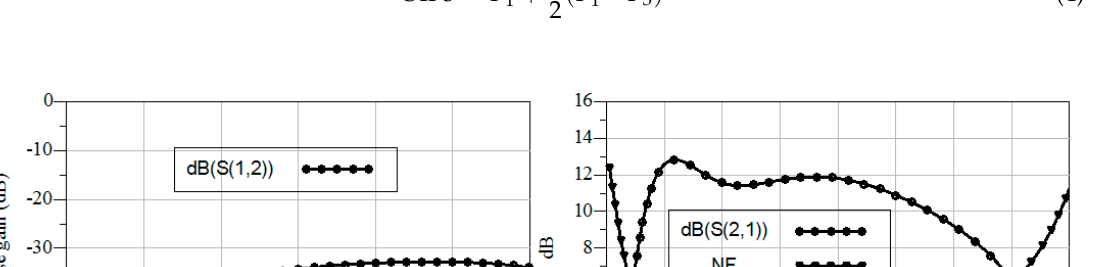
Figure 5. Simulated results of: ( a ) input/output reflection coefficients and, ( b ) LNA Stability Figure 6. Simulated results of: ( a ) isolation , and ( b ) Simulated results of power gain and noise figure (NF).